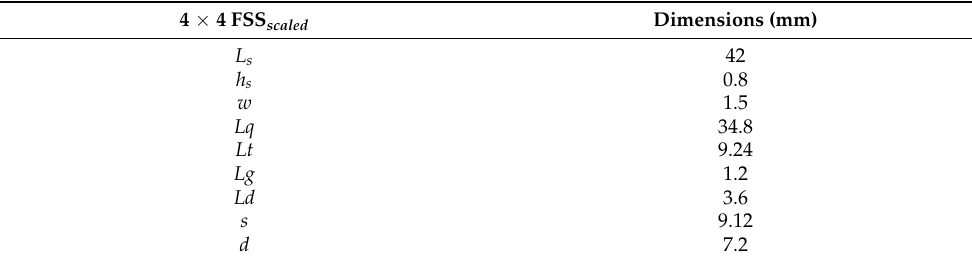
Table 2. Unit cell dimensions of the FSS scaled prototype.